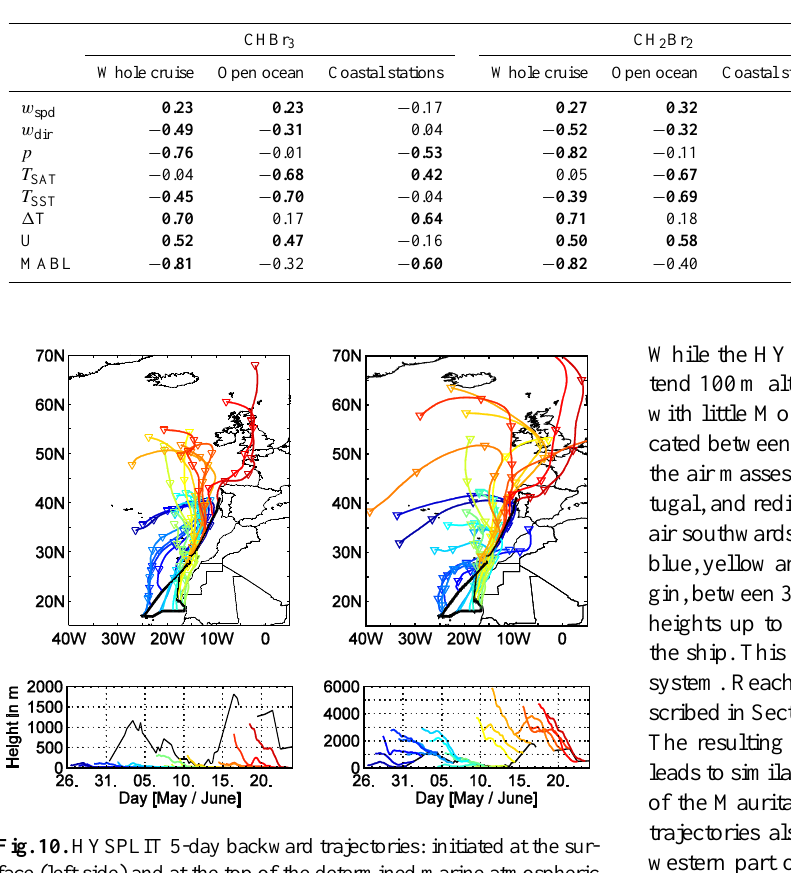
Table 3. Correlation coefficients of bromoform (CHBr 3 ), dibromomethane (CH 2 Br 2 ) and methyl iodide (CH 3 I) mixing ratios with wind speed ( w spd ), wind direction ( w dir ), surface air pressure ( p ), surface air temperature ( T SAT ), sea surface temperature ( T SST ), temperature difference ( 1T = T SAT – T SST ), relative humidity ( U ), and MABL height. Whole cruise (leg 2 and 3) includes n = 181 samples for all param- eters except MABL height (30 samples), open ocean (leg 2, except stations 3–6 and leg 3) includes n = 85 samples for all parameters except MABL height (15 samples) and coastal stations (stations 3–6) include n = 96 samples for all parameters except MABL height (15 samples). Bold coefficients have a p value of less than 5%.